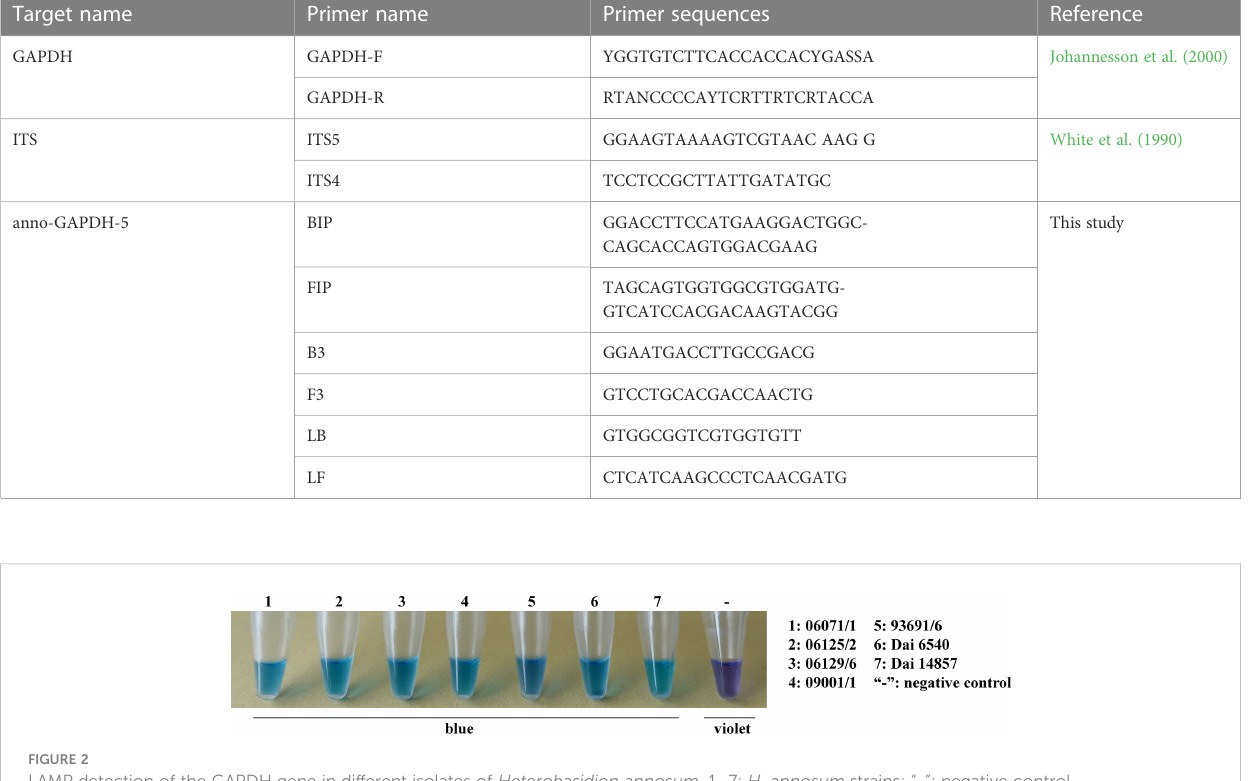
TABLE 2 Primers used in this study.